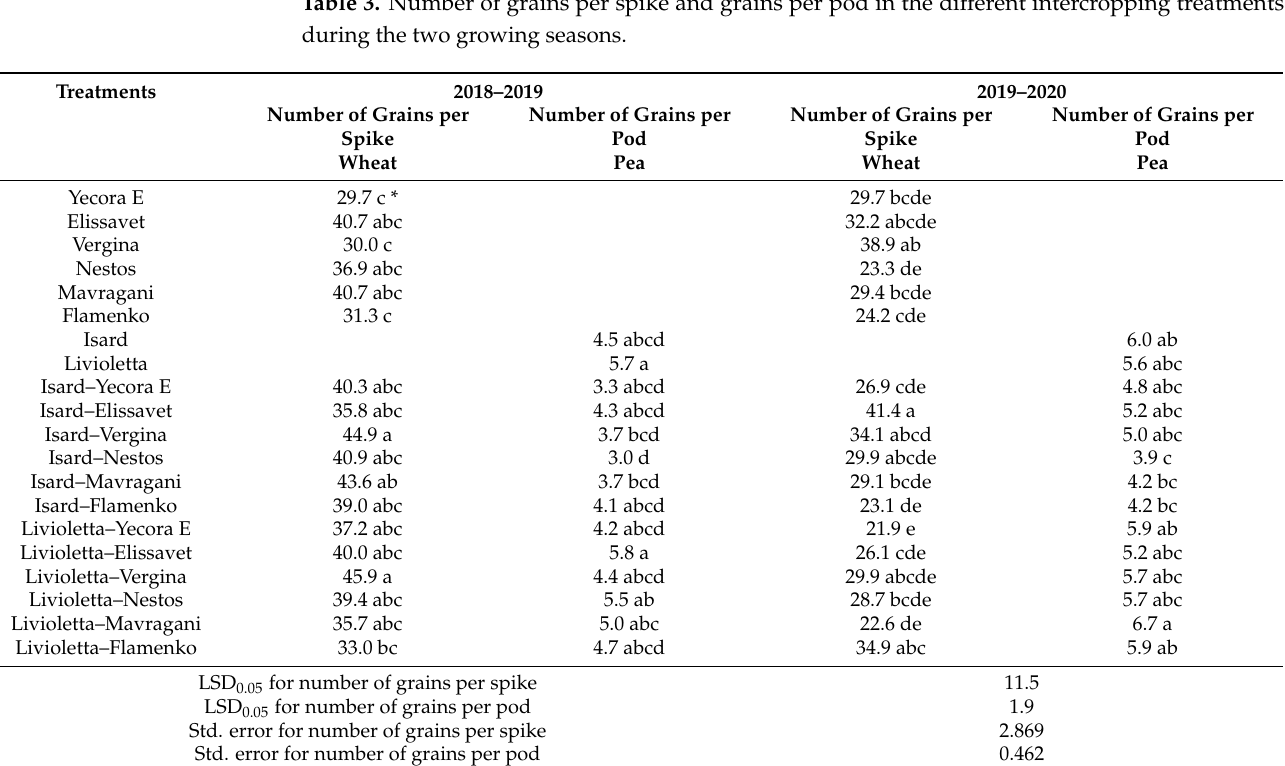
Table 3. Number of grains per spike and grains per pod in the different intercropping treatments during the two growing